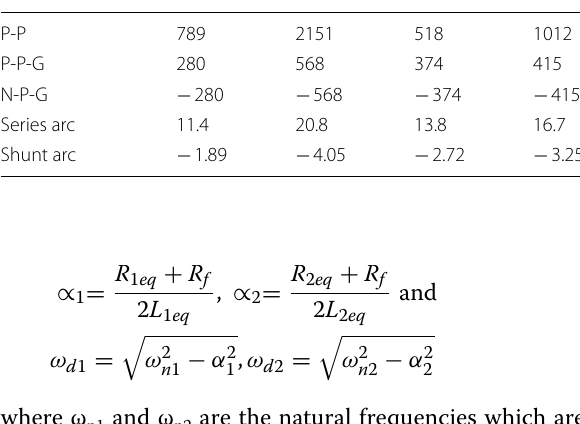
Table 3 Different DC faults current threshold range under fault resistance and distance variations Different faults under R f variation Different faults Type of